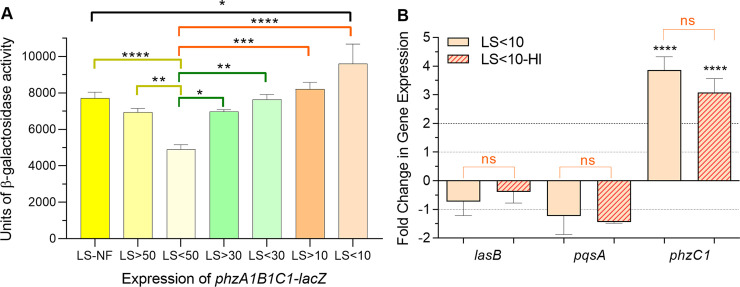
Different fractions of LBBS enhanced phzA1B1C1 expression.(A) LBBS was fractionated using molecular weight cut-off columns of 50-, 30-, and 10-kDa. PAO1/pMW303, which carries a phzA1B1C1-lacZ transcriptional reporter fusion, was grown for 16 h post-inoculation in nonfractionated LBBS (LS-NF) or fractionated LBBS (LS>50, LS<50, LS>30, LS<30, LS>10 and LS<10). Cell pellets were collected and lysed, and β-galactosidase activity within the lysates was determined. Values represent the means of 3 independent experiments ± SEM. Significance was determined by one-way ANOVA with Dunnett’s multiple comparisons posttest using LB<50 as the control; *, P <0.05; **, P <0.01; ***, P <0.001; ****, P <0.0001. (B) Fraction LS<10 enhanced expression of phzC1 but not lasB or pqsA. PAO1 was grown for 8 h post-inoculation in LBB, LS<10, or LS<10 that had been heat inactivated by boiling for 15 min (LS<10-HI). Expression of lasB, pqsA, and phzB2 was determined by qRT-PCR. Fold change in gene expression at each time point is relative to its expression in LBB at the same time point (value of 1, dotted line). Values represent the means of 3 independent experiments ± SEM. Significance was determined by two-tailed t-test and the cut-off of ≥ twofold (dashed line); ns, no significant difference; ****, P <0.0001.